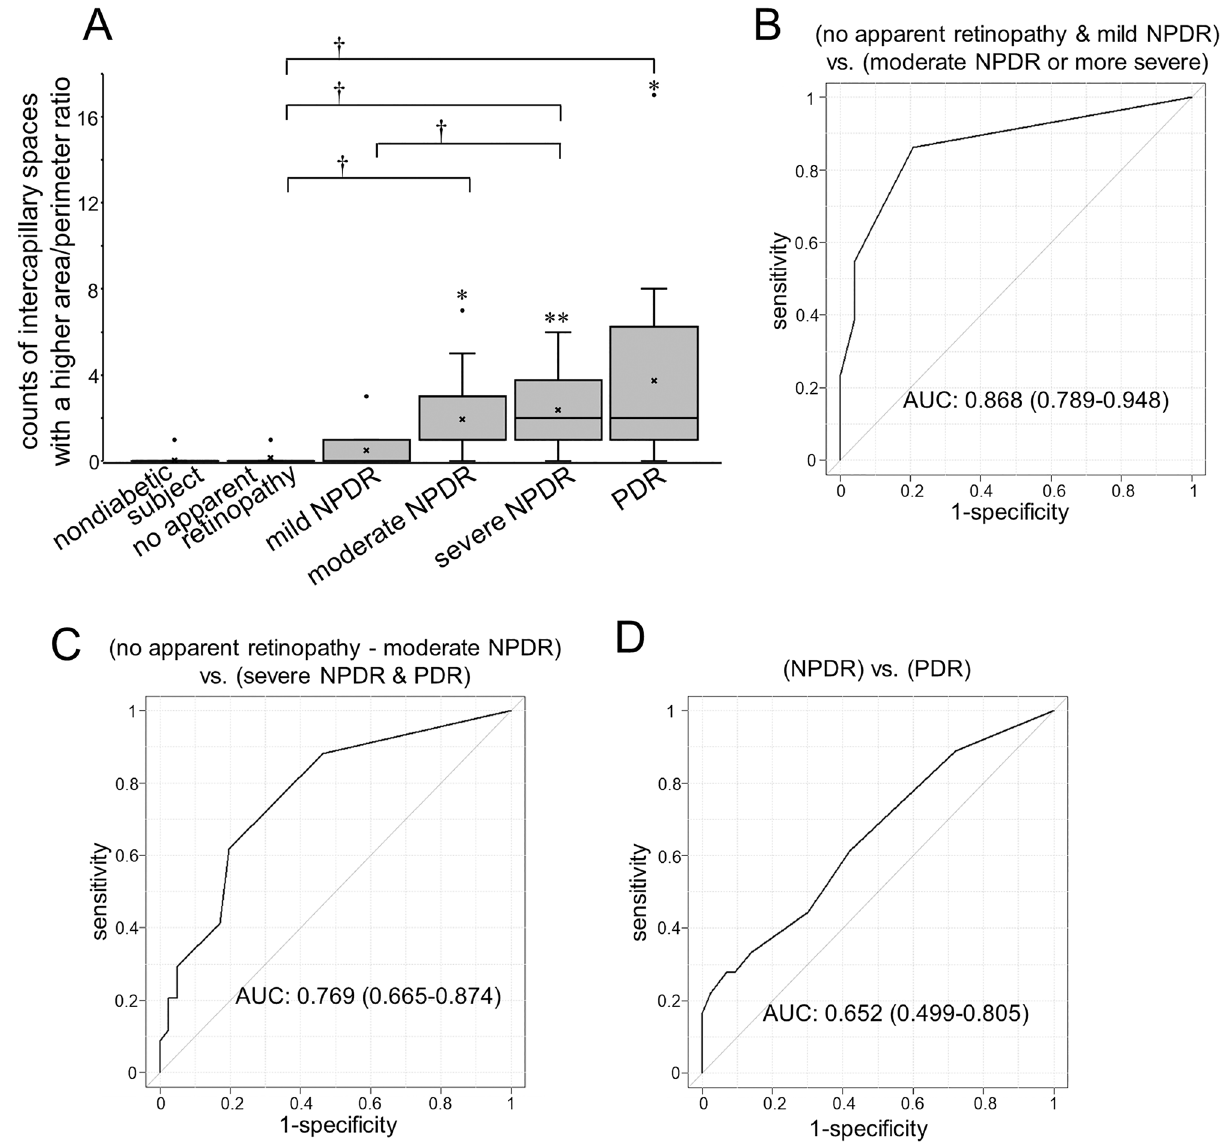
Figure 6. The numbers of intercapillary spaces with an increased area/perimeter ratio. ( A ) The numbers of intercapillary spaces with an area/perimeter ratio greater than 0.025 (A.U.) increase according to the DR severity grades. * P < 0.05, ** P < 0.01 versus nondiabetic eyes. † P < 0.05 versus no apparent retinopathy or mild NPDR. The ROC curves to discriminate referable DR from no apparent retinopathy and mild NPDR ( B ); severe NPDR and PDR from no apparent retinopathy, mild NPDR, and moderate NPDR ( C ); and PDR from NPDR ( D ). The AUC shows the significant power of intercapillary spaces with an area/perimeter ratio greater than 0.025 (A.U.) to discriminate referable DR from no apparent retinopathy and mild